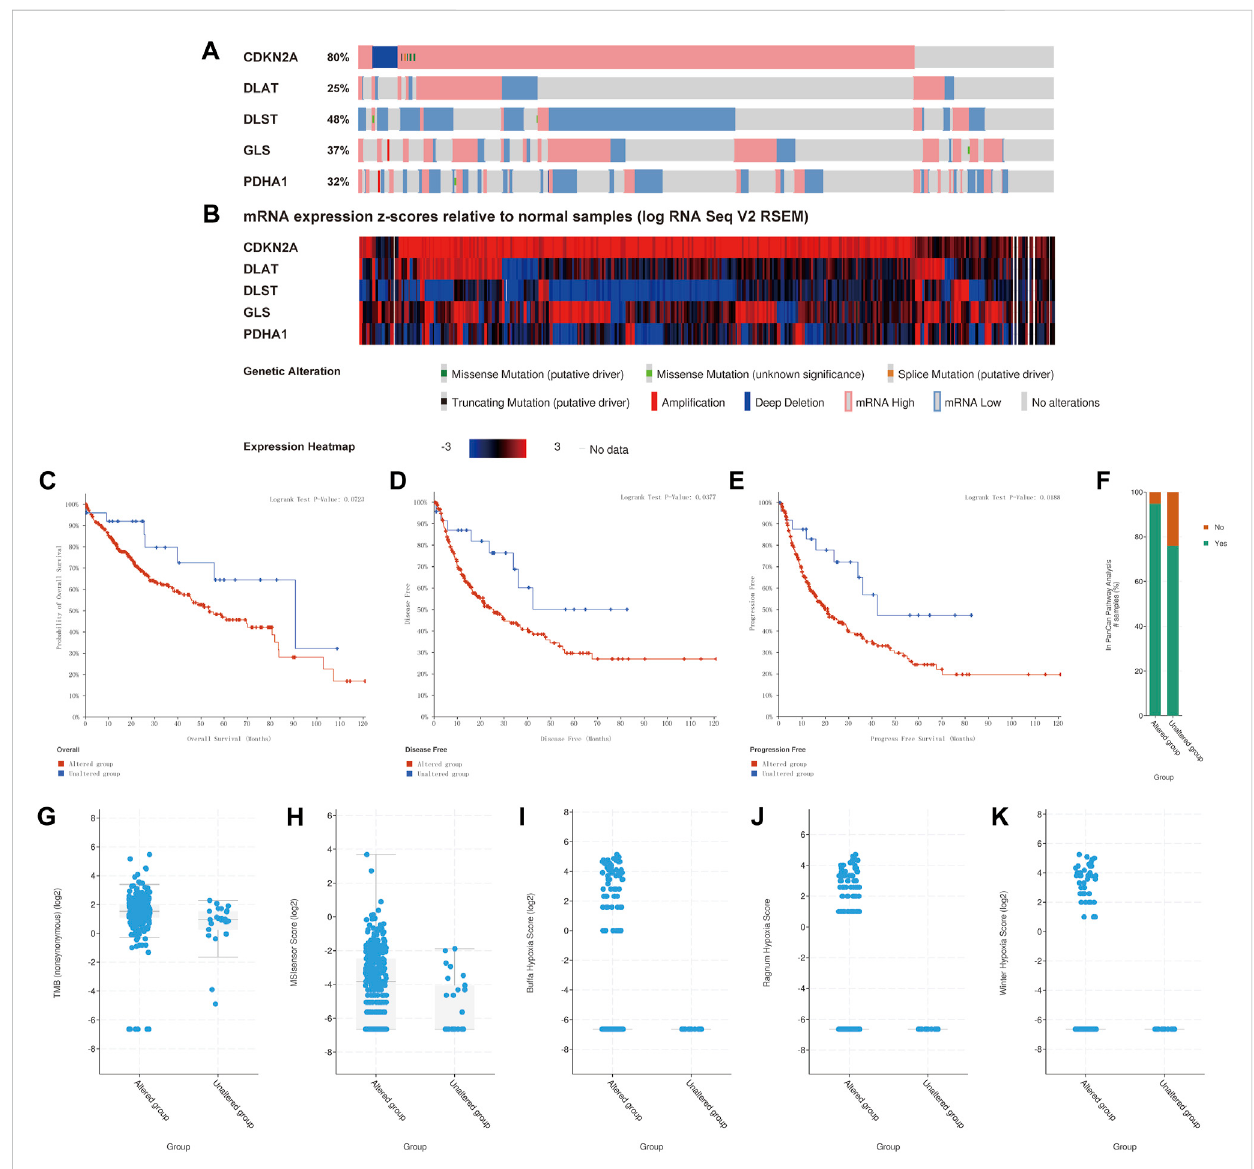
FIGURE 9 AssociationofgenemutationsinprognosticCRGswithsurvivalandclinicaloutcomesofHCCpatients(cBioPortal). (A) MutationrateofprognosticCRGsin HCC patients. (B) mRNA expression z-score of prognostic CRGs in HCC tissue samples relative to normal samples. (C – E) CRG mutations in liver cancer tissues associated with shorter OS, DFS, and PFS in HCC patients. (F – K) CRG mutations in HCC tissues upregulated cancer progression-related scores, including